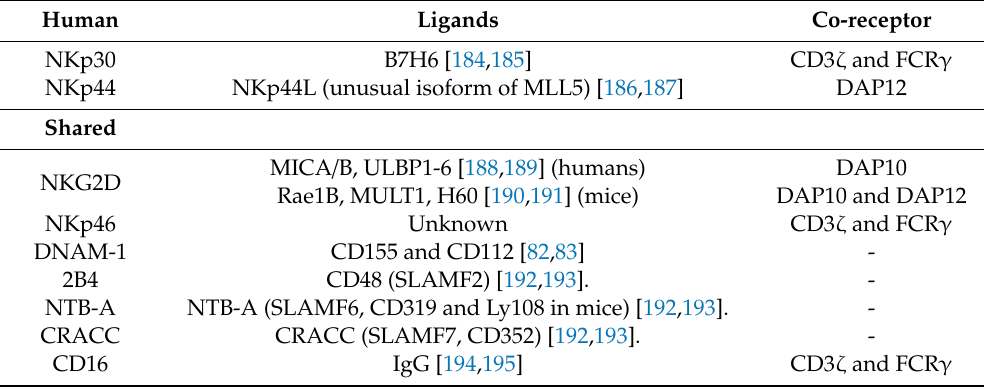
Table 4. Activating NK receptors paired to cellular ligands and signaling